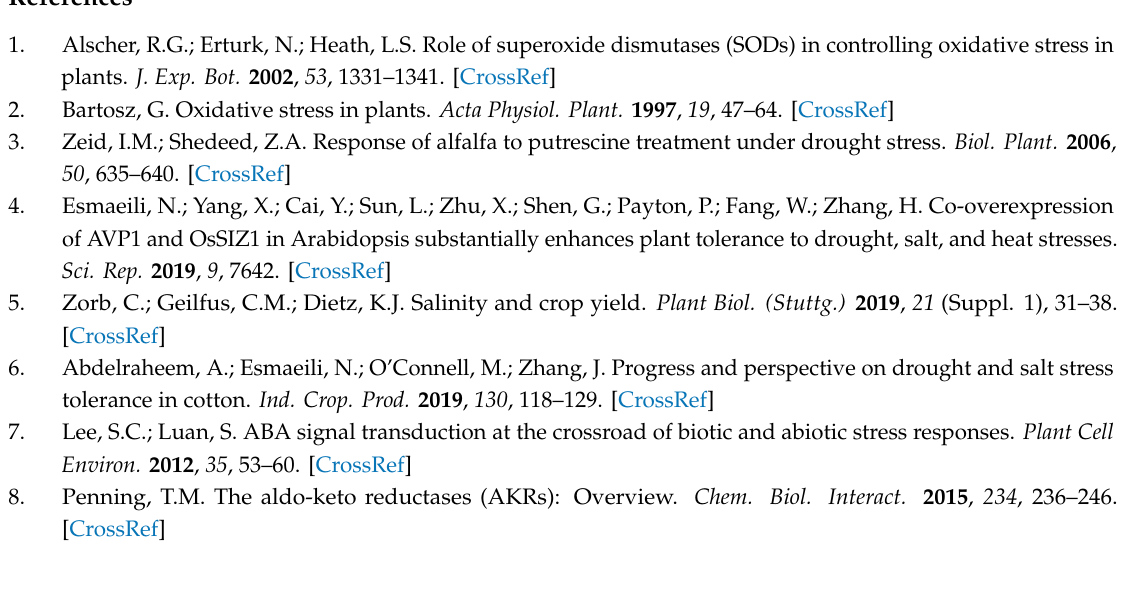
Figure S1: The logo of ten MtAKRs motif construction. Each logo consists of stacks of symbols, one stack for each position in the sequence. The conservation at each position is indicated by the overall height of the stack. The height of symbols within the stack is proportional to frequency of each amino acid at that position. Table S1: The qRT-PCR primers of MtAKRs . Table S2: The data of gene expression in qRT-PCR (leaf). Table S3: The data of gene expression in qRT-PCR (root). Table S4: Relative expression levels (FC) in roots and leaves of Medicago